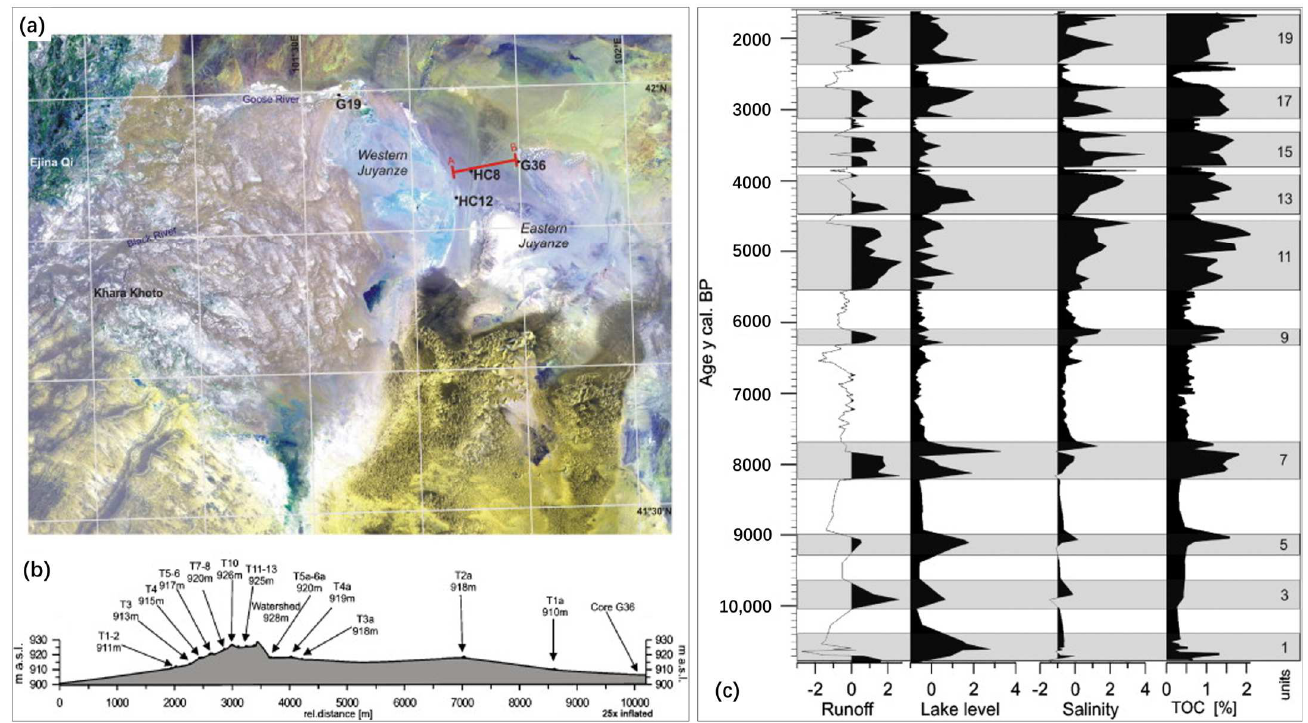
Figure 4. Landsat satellite image (Landsat ETM+, RGB 7-4-2) of the Juyanze palaeolake area ( a ), cross-section through the western and eastern sub-basins with measured shorelines ( b ), and factor values plotted against the age model ( c ) in the northwestern part of the Alashan Plateau [46]. TOC, total organic carbon.